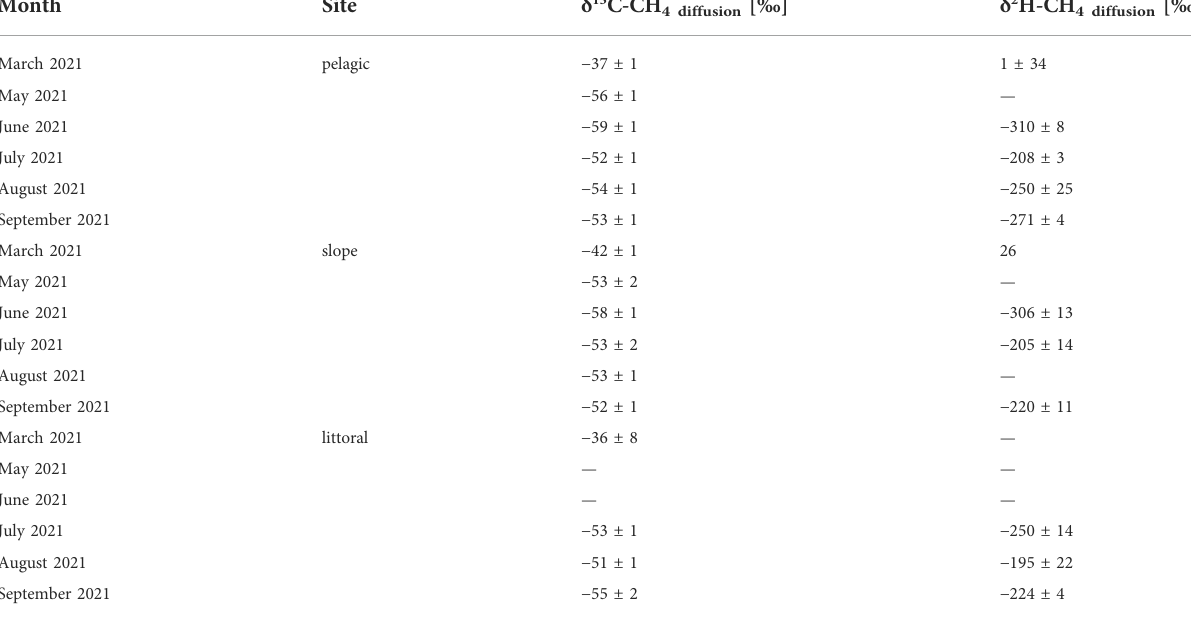
TABLE 2 δ 13 C-CH 4 and δ 2 H-CH 4 values of diffusively released CH 4 from the lake surface water into the atmosphere.